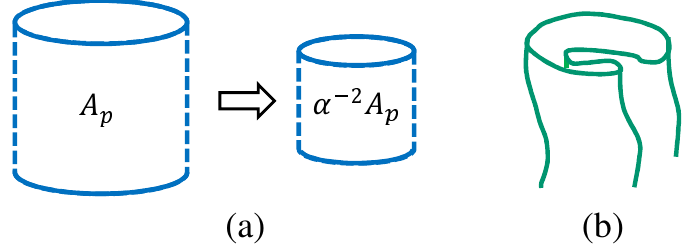
Figure 5. ( a ) An illustration of the change in the projected area α − 2 A p , which restores the original A p and remains unchanged under the scale change r → α r in the partition function, and ( b ) a possible folding of the surface (which is magnified; this type of folding is always